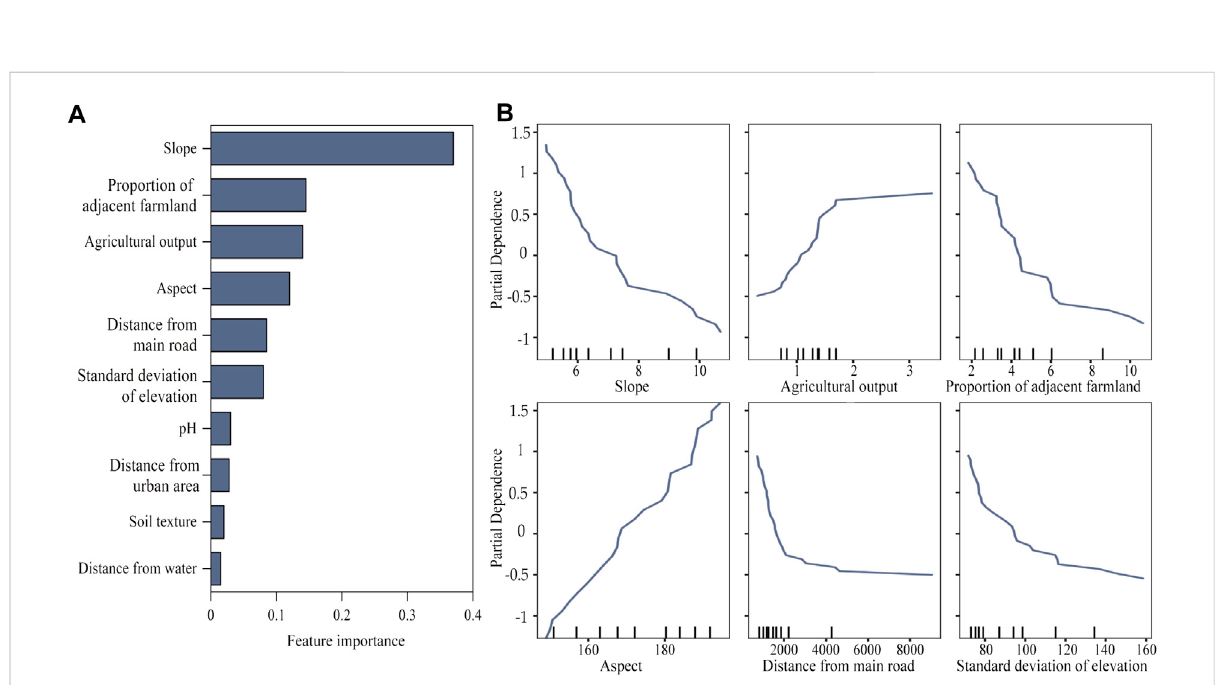
FIGURE 11 Feature importanceandpartial dependenceofselected in fl uencingfactors onorchardexpansion. (A) Showsthefeature importance ofprimary in fl uencing factors on orchard expansion. (B) Shows the partial dependence of the fi rst six in fl uencing